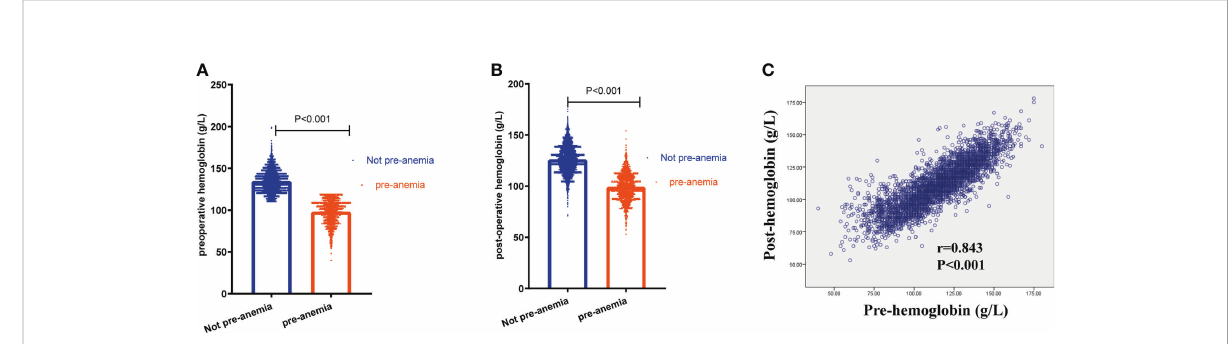
FIGURE 2 Preoperative anemia was associated with more postoperative anemia. (A) The level of preoperative hemoglobin in patients with and without preoperative anemia (pre-anemia) (133 ± 12.1 g/L vs . 98 ± 14.2 g/L, n=1690 in each group, P<0.001). (B) The level of postoperative hemoglobin in patients with or without pre-anemia (124 ± 13.3 g/L vs . 99 ± 13.1 g/L, P<0.001, n=1690 in each group). (C) The correlation between preoperative hemoglobin (pre-hemoglobin) and postoperative hemoglobin (post-hemoglobin) using Spearman analysis. Signi fi cance with P <